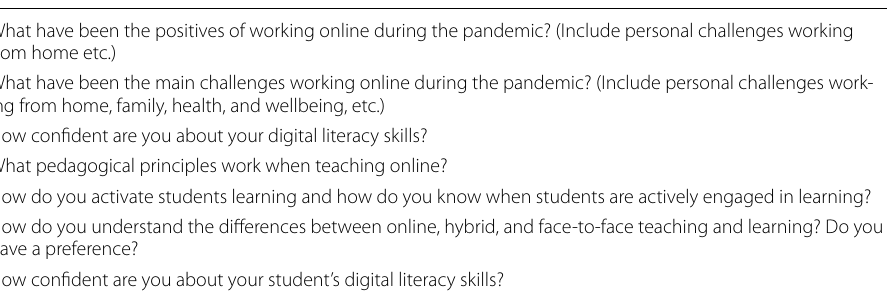
Table 1 Reflective questions Questions to the Swedish and Australian